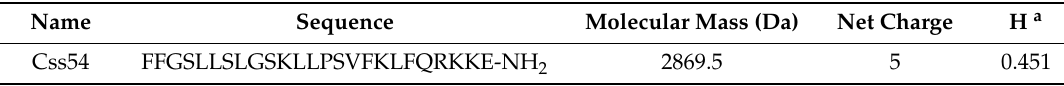
Table 1. Amino acid sequence and properties of Css54.